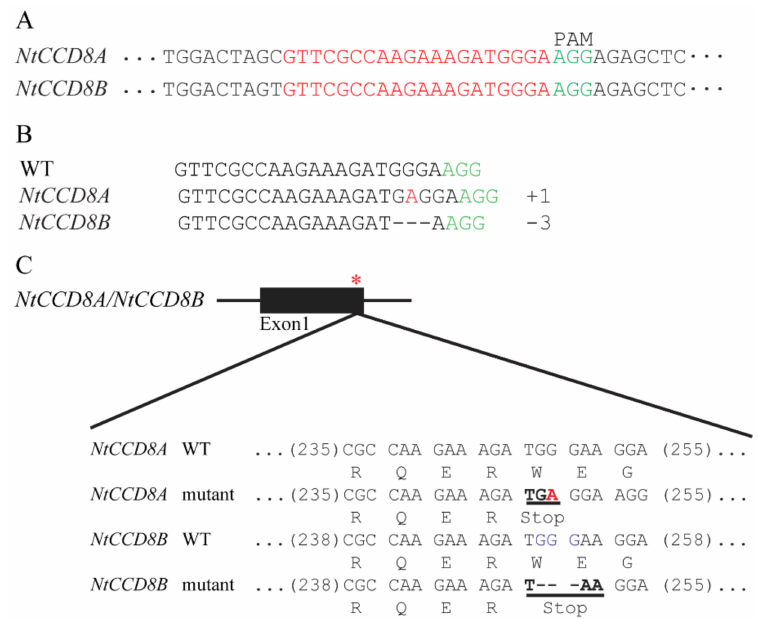
Figure 3. CRISPR/gRNA-mediated NtCCD8 genes disruption. ( A ) The common target site selected for targeted NtCCD8A and NtCCD8B mutation. The target region is indicated by the nucleotides in red followed by PAM (proto-spacer adjacent motif). ( B ) Sequences of the mutated sites in homozygous ntccd8 mutant plants. Deletions and insertions are indicated by dashes and red letters, and the numbers on the right side indicate the size of the deletions and insertions. ( C ) Schematic representation of the mutated position in ntccd8 mutant plants. The position of premature stop codons caused by deletions and insertions is indicated by a red asterisk, the deleted “GGG” and inserted “A” bases are shown in blue and red lettering, respectively, and premature stop codons are shown in